Question: Summarize what this figure shows in one sentence.
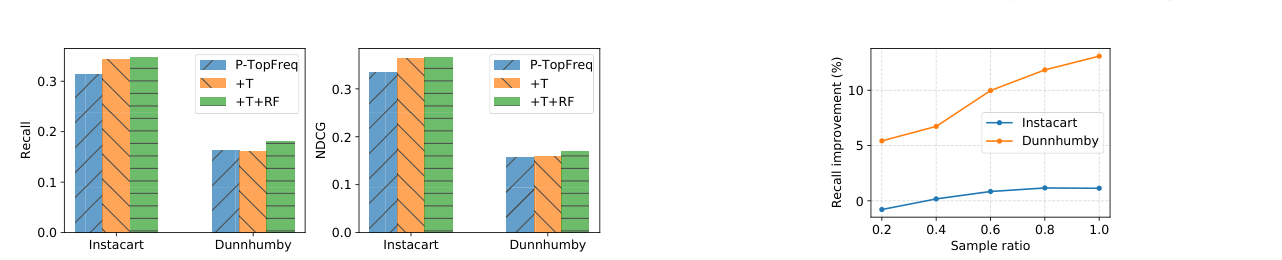
Answer: Performance of TREx-Rep when we add a time- decay factor 𝛽(+T), add both 𝛽and item-specific repetition feature 𝑅𝑒𝑝𝐼(𝑖) (+T+RF).